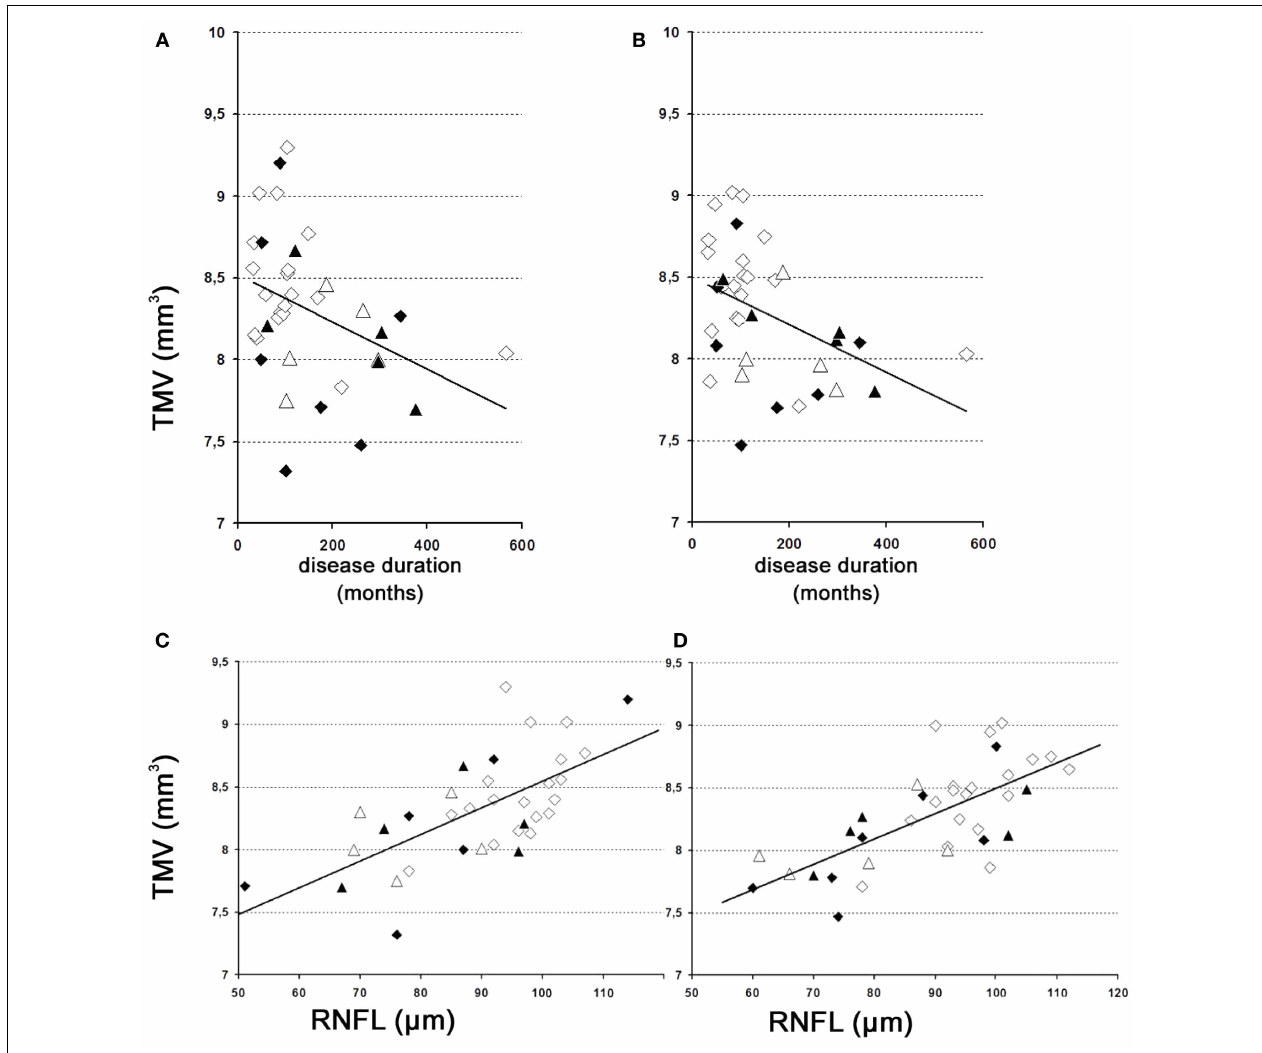
y = 6.4 + 0.02 × x [correlation coefficient = 0.7; R 2 = 47.9%; standard error of estimate = 0.3]. (D) Right eye – moderately strong relationship between TMV and RNFL. y = 6.4 + 0.02 × x [correlation coefficient = 0.7; R 2 = 48.5%; standard error of estimate = 0.3]. (A) Left eye; (B) right eye; (C) left eye; (D) , right eye; white squares, RRMS without ON; black squares, RRMS with ON; white triangles, SPMS without ON; black triangles, SPMS with